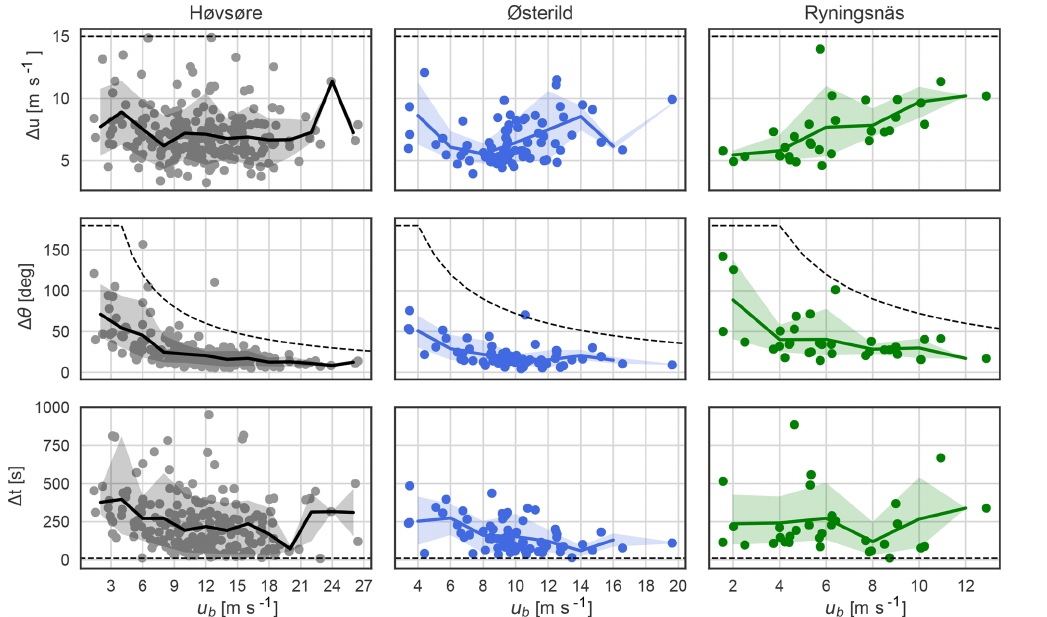
Figure A1. The detected amplitudes ( (cid:49)u ), direction changes ( (cid:49)θ ), and rise times ( (cid:49)t ) as a function of speed preceding the ramp ( u b ) at the different sites: Høvsøre (grey), Østerild (blue), and Ryningsnäs (green). The plots share the primary axis (abcissa) per column and they share the secondary axis (ordinate) per row. The black dashed lines show the ECD